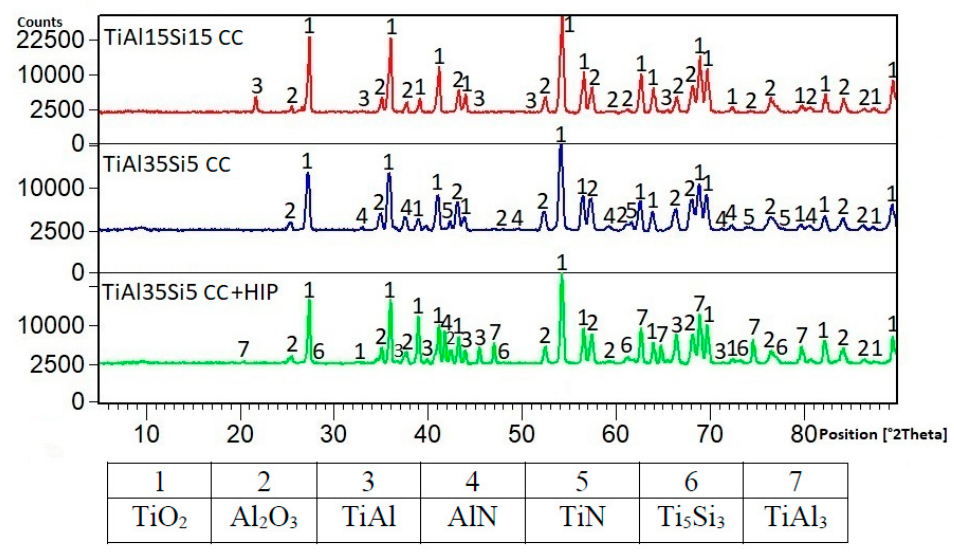
Figure 9. Phase composition of the surface oxide layer of Ti-Al-Si alloys after cyclic oxidation at 1000°C.